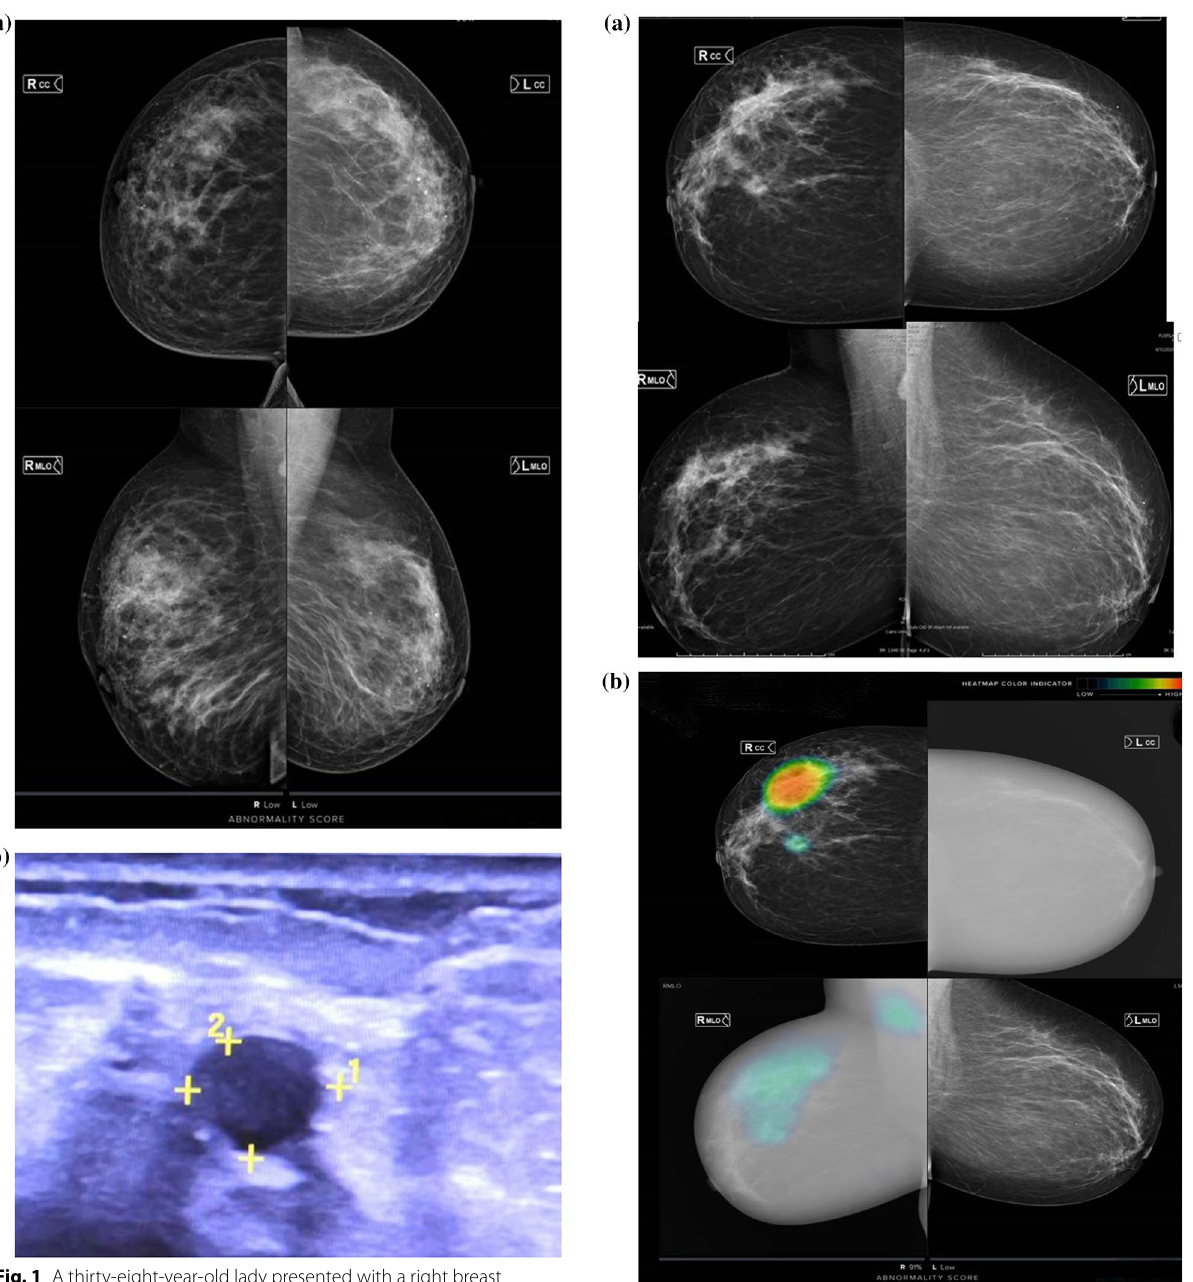
Fig. 2 A forty-two year-old lady came complaining of a lump sensation in the right breast, Mammography showed right breast UOQ focal asymmetry with mild distortion BIRADS4. a Complementary US revealed right UOQ area of altered parenchyma. AI software revealed right breast upper outer quadrant showed an overlaid heat map, highlighting the area of suspicion with PoM scoring 91% indicating a malignant lesion ( b ). The final diagnosis was Granulomatous